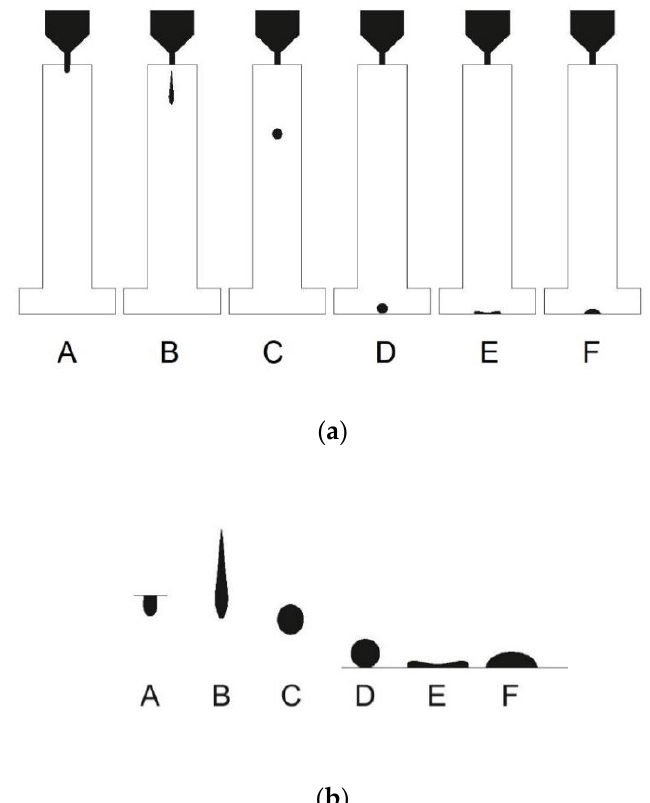
Figure 1. Droplet fall/movement. ( a ) During the inkjet printing processes, the droplet is ejected from the inkjet nozzle and settles while changing its shape at different stages (A–F); ( b ) Highlighted inkjet droplet phases at different stages (A–F). Phases from the left: A—ejection and formation of the droplet; B—droplet pinch off from the nozzle; C—droplet sphere forming; D—droplet before the interaction with the surface; E—droplet spreading at the surface; F—droplet in final stable form. At point A, the ejection and formation of the droplet comes along with the maximum droplet velocity, then pressure inside the nozzle reaches its maximum and the droplet is ejected from the nozzle. At point B, the droplet thread is pulled off from the printhead nozzle, at this point the droplet has its maximum length and final droplet mass and volume. Point C represents the droplet at almost spherical form when the droplet is formed. Before point C and D, the droplet does not change shape and loses velocity during its settling. Point D represent the instance where droplet interaction with the surface begins, and view E represents the droplet at maximum diameter while spreading. Final point F represents the droplet while oscillating to its final stable